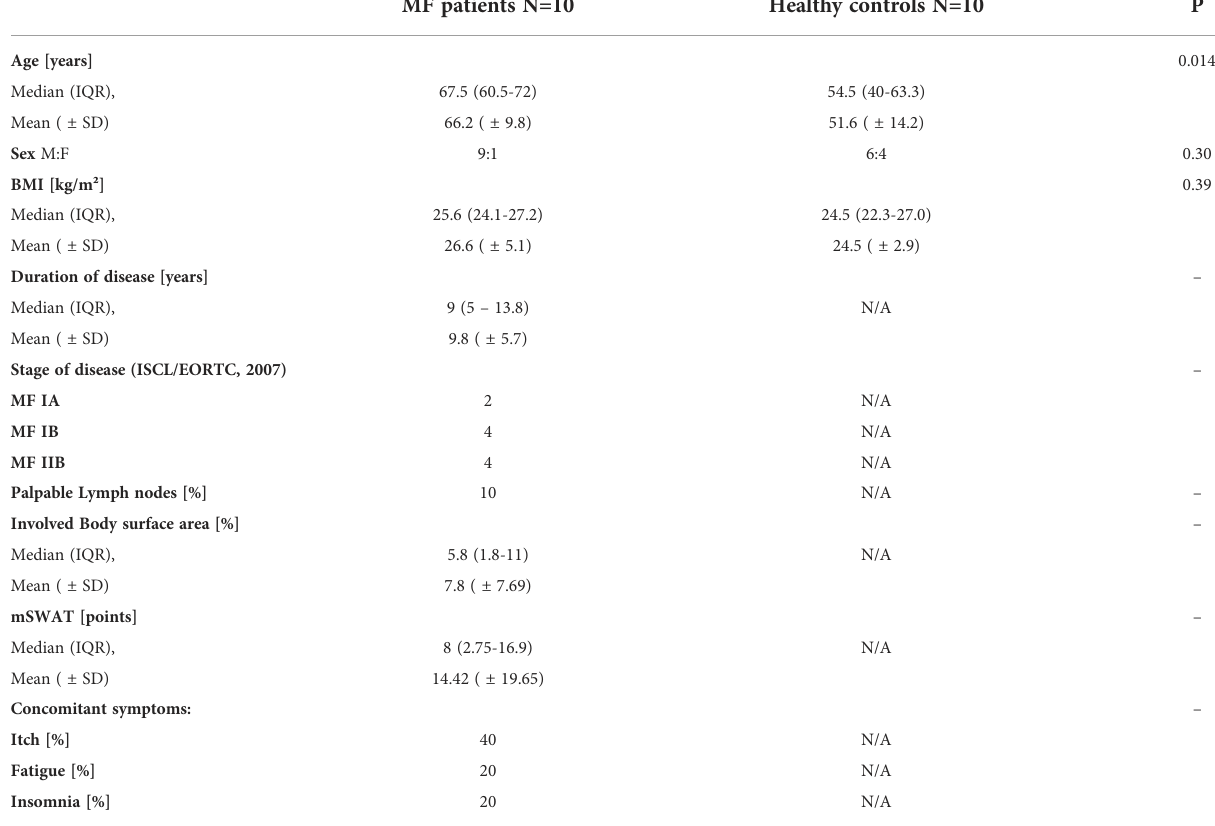
TABLE 1 Clinical characteristics of study